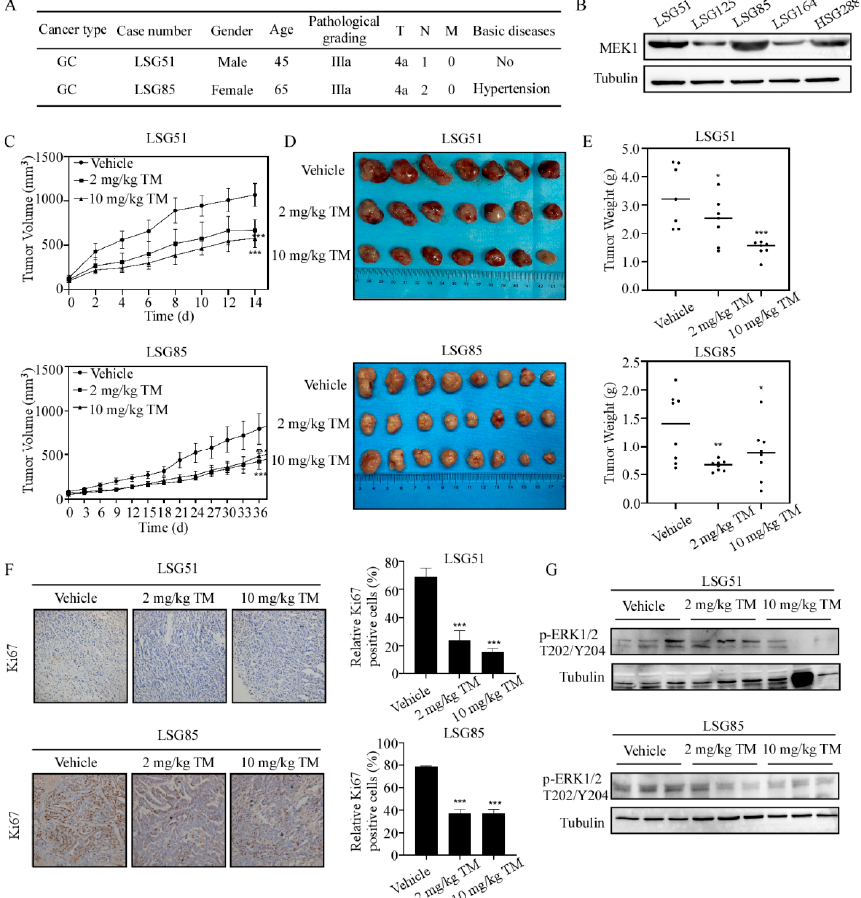
Figure 5. Tegaserod maleate inhibits the growth of GC PDX. ( A ) Patients’ information for samples used in the GC PDX models. ( B ) The protein levels of MEK1 in different PDX cases. ( C ) The change of average tumor volume in different groups of LSG85 and LSG51 cases after tegaserod maleate treatment. ( D ) Tumor images of different groups after sacrifice. LSG85 (n = 8), LSG51 (n = 7). ( E ) Tumor weight analysis in different groups of LSG85 and LSG51 cases after tegaserod maleate treatment compared with the average tumor weight of the vehicle group. ( F ) Left panel: Representative IHC images of LSG85 and LSG51 tumor tissue slices (100 magnifications), tumor tissues were stained with Ki-67 antibody; Right panel: Statistical analysis of IHC positive staining of Ki-67 in both LSG85 and LSG51 cases. ( G ) The protein levels of p-ERK1/2T202/Y204 in tumor tissues were detected using Western blotting. The asterisks (*) (**) (***) indicate a significant ( p < 0.05, 0.01 and